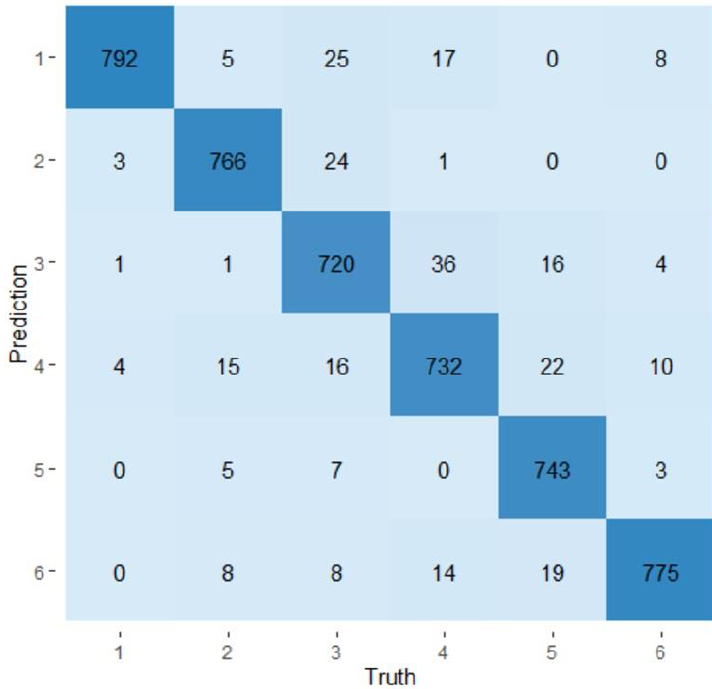
Figure 5. Confusion matrix of the visit model. The x -axis line indicates the identity of the six visits and the y -axis line shows the prediction of a sample visit based on its microbiota. 1: Visit one; 2: Visit two; 3: Visit three; 4: Visit four; 5: Visit five; 6: Visit six.